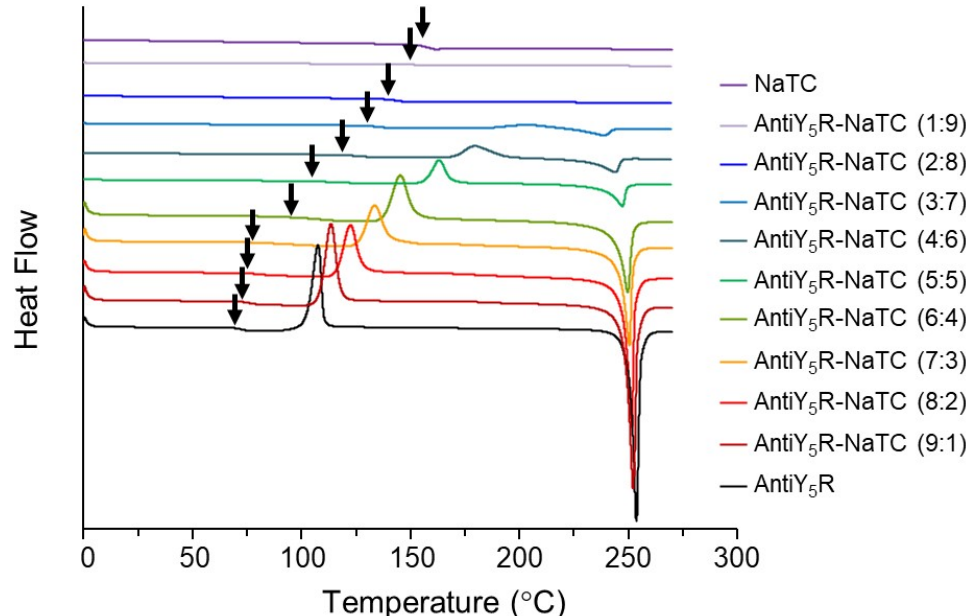
Figure 4. Typical DSC profiles of AntiY 5 R, NaTC and mixtures of AntiY 5 R and NaTC at different molar ratios. Amorphous samples of AntiY 5 R and AntiY 5 R-NaTC (9:1) to AntiY 5 R-NaTC (6:4) were prepared by the rapid cooling of their melted samples with liquid nitrogen. Amorphous samples of NaTC itself and AntiY 5 R-NaTC (5:5) to AntiY 5 R-NaTC (1:9) were prepared by cooling cycle during DSC measurement. The black arrows indicate the Tgs .